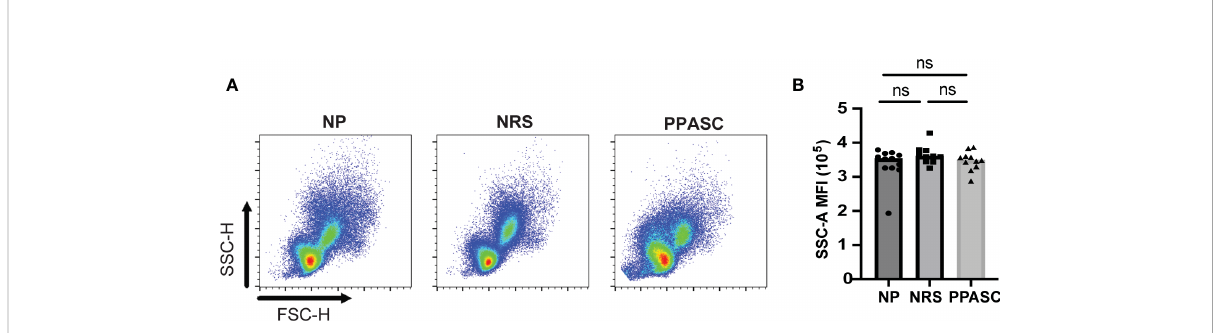
FIGURE 3 Granularity of LDGs after SARS-CoV-2 Infection. Morphology (size and granularity) of LDGs were analyzed by fl ow cytometry. Gating strategy for identi fi cation of granularity on LDG after gating on CD45 + CD11b + CD16 + CD14 - CD15 + cells (A) . Mean granularity of LDGs based on sideward scatter/area of intensity (SSC-A) in NP, NRS, and PPASC (B) . Graphs are shown as bar with scatter dot plots. Comparisons between groups were performed using Mann-Whitney U test. ns, non-signi fi cant, p > 0.05.